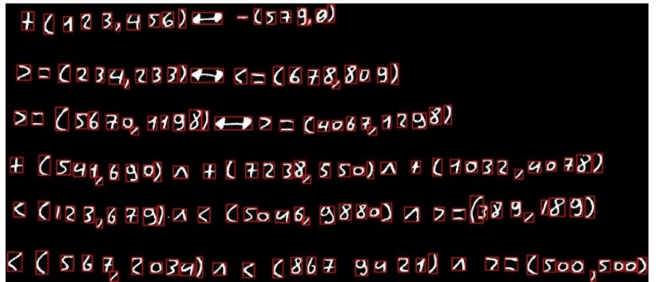
Figure 4. Example of contours extraction.